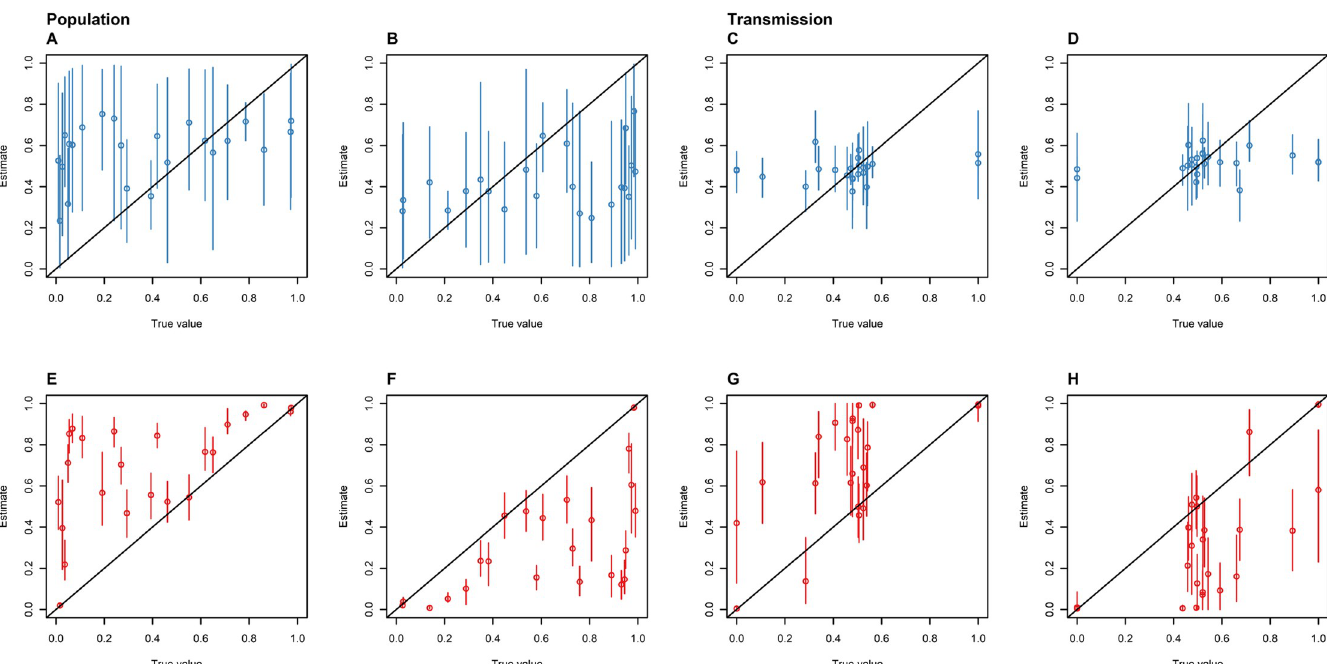
Fig 7. The proportion of time spent in the animal (A and E) and human (B and F) host populations, and the proportion of inter-population transmissions made up of animal-to-human (C and G) and human-to-animal (D and H) transmissions as estimated by the SC (blue: A-D) and DTA (red: E-F) models versus the true parameters for 23 simulated outbreaks that 100 isolates were randomly sampled from. The diagonal line represents accurate parameter estimates of the sampled outbreaks, the dots represent the mean, and the error bars represent the 95% HPD